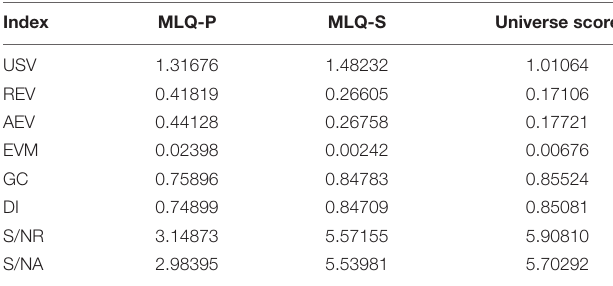
TABLE 3 | Estimated MGT D study statistics for the MLQ.